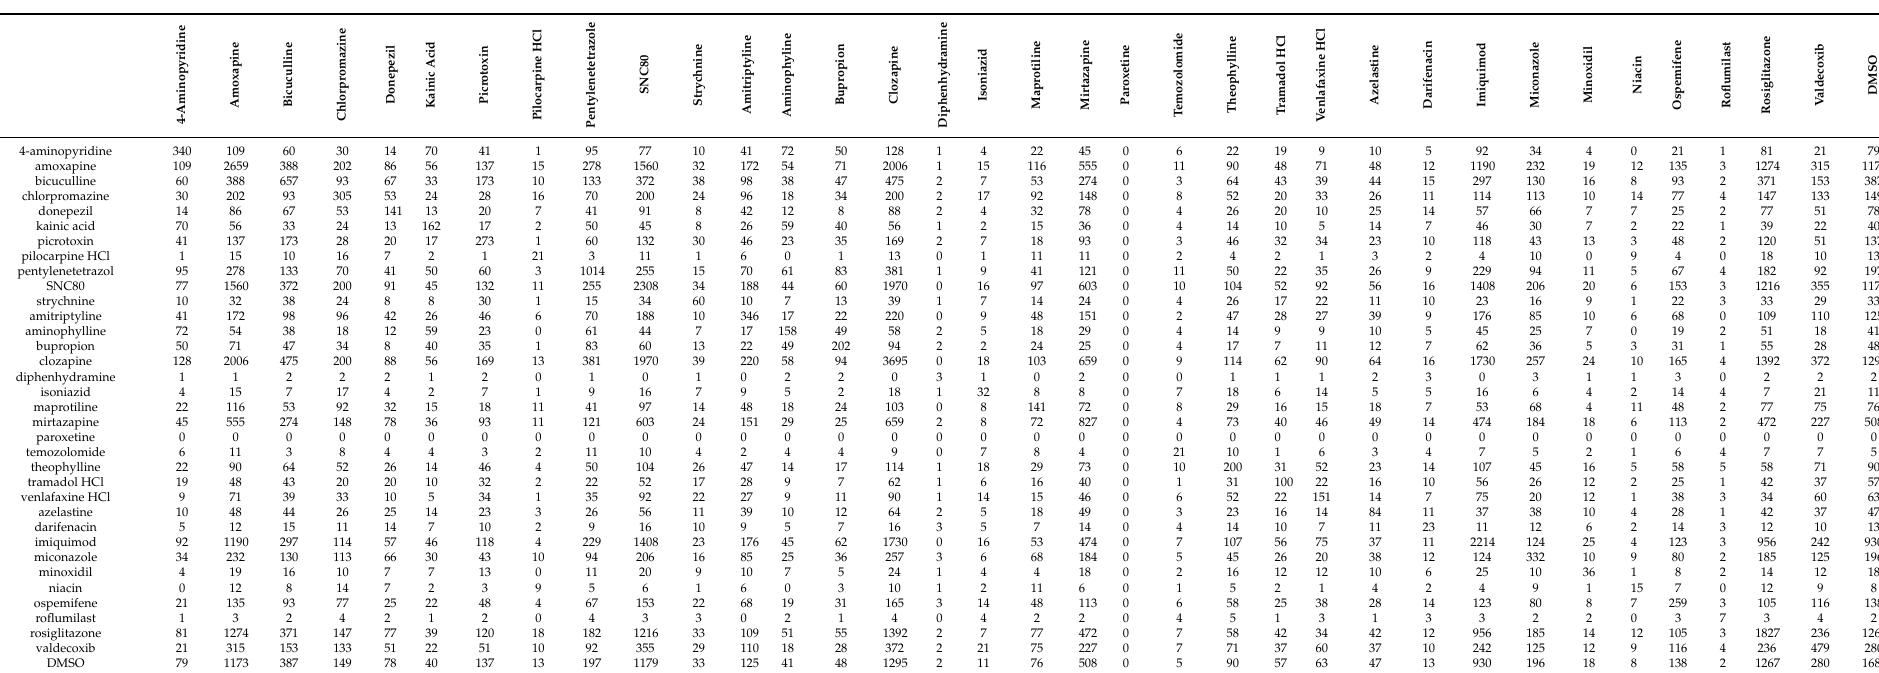
Table 3. Cross-tabulation of the differentially expressed (DE) genes (FDR < 0.05 and log2(|FC|) > 1.5) induced by the tool, FAERS-positive, and FAERS- negative